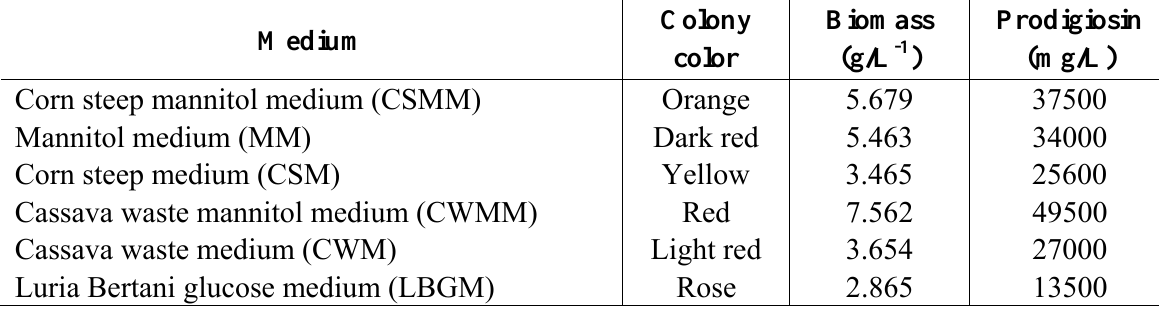
Table 1. Colony color, biomass and prodigiosin production by S. marcescens in different media for 48 h at 28 °C.